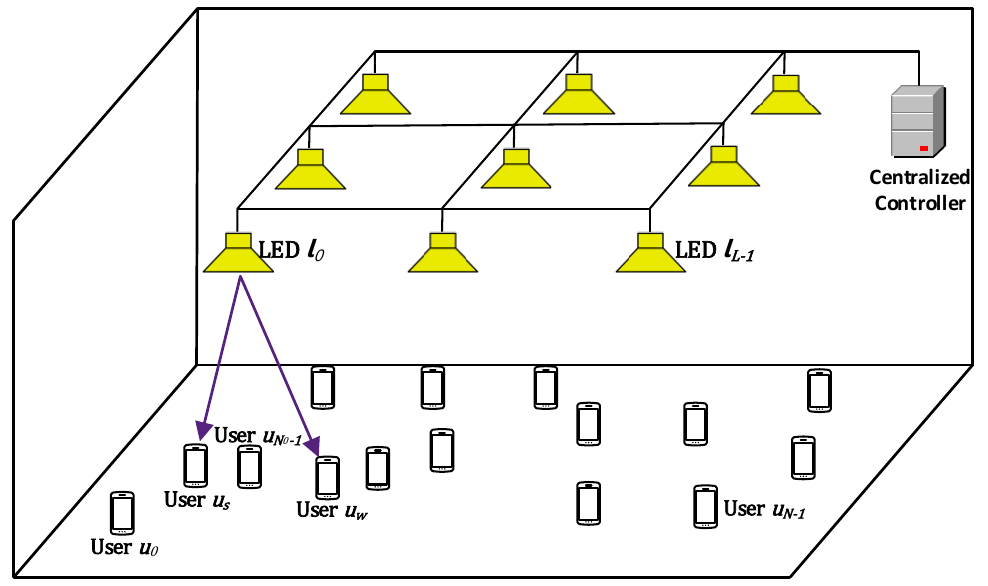
Figure 1. The C-LiAN architecture